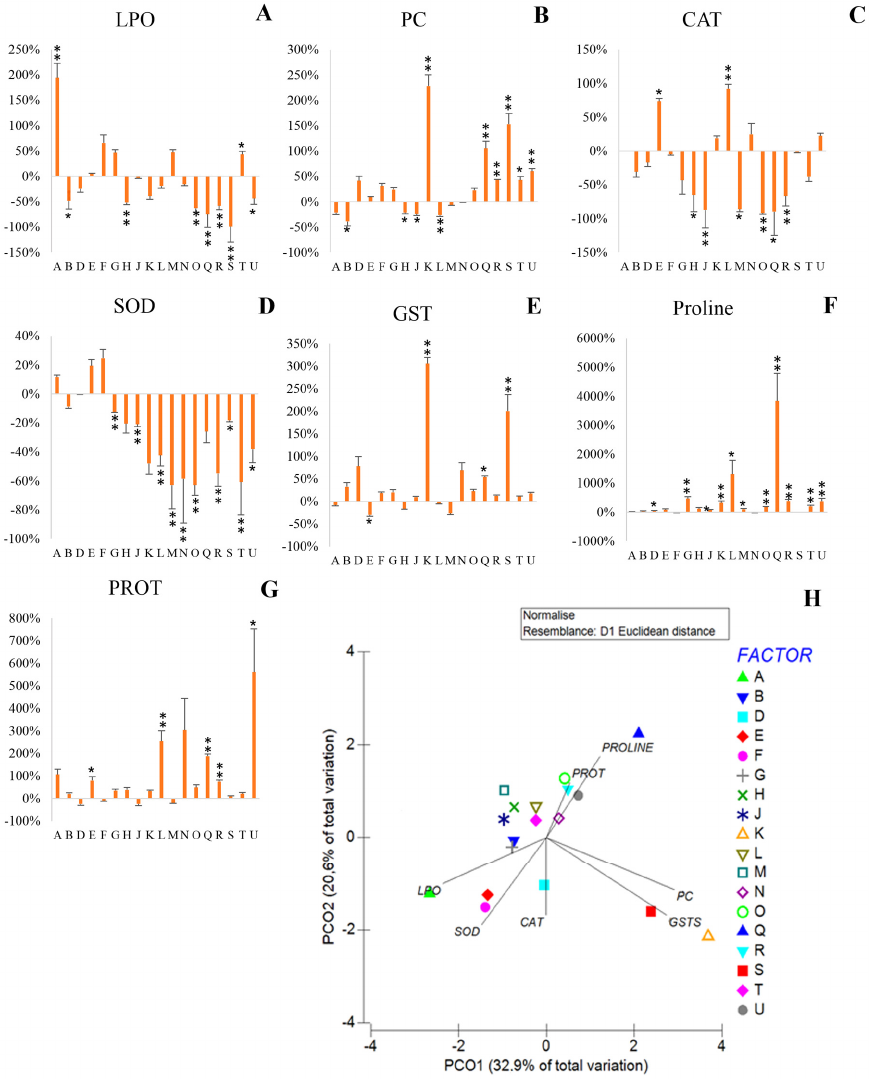
Figure 3. Effect of salinity on bacterial strains biochemistry: ( A ) Lipid peroxidation, ( B ) Protein car- bonylation, ( C ) Catalase, ( D ) Superoxide dismutase, ( E ) Glutathione S-Transferase, ( F ) Proline, ( G ) Protein, ( H ) principal coordinates ordination of biochemical parameters under saline stress. Bio- chemical markers variation of bacterial cells exposed to IC 50 NaCl relatively to control (not exposed to NaCl) are superimposed. Bacterial strains: Pantoea sp. (A); Klebsiella sp. (B); Pseudomonas sp. (D); Pseudomonas sp. (E); Acinetobacter sp. (F); Stenotrophomonas sp. (G); Enterobacter sp. (H); Enterobacter sp. (J); Pantoea sp. (K); Pseudomonas sp. (L); Rhizobium sp. (M); Paenarthrobacter sp. (N); Ochrobactrum sp. (O); Pseudomonas sp. (Q); Rhizobium sp. (R); Stenotrophomonas sp. (S); Pseudomonas sp. (T); Enterobacter sp. (U). Values are means of three replicates. Significant differences compared to control (non-inoculated and non-salt exposed plants) were marked with single asterisks ( p < 0.05) or double asterisks ( p < 0.01). Means, standard deviation and statistical significance are included in Supple- mentary Table S3.